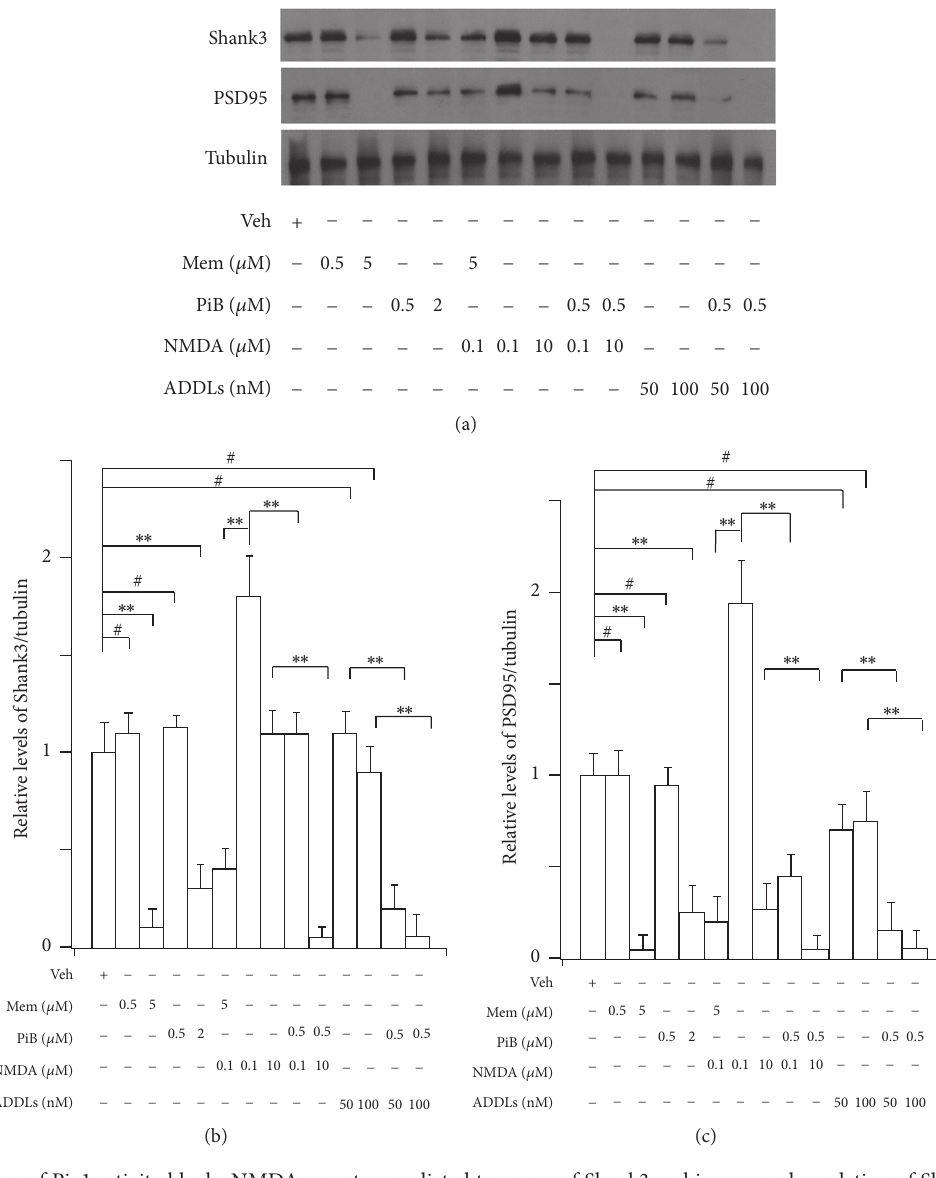
Figure 6: Blocking of Pin1 activity blocks NMDA receptor-mediated turnover of Skank3 and increases degradation of Shank3 and PSD95 induced by oligomers of A 𝛽 and NMDA in cultured neurons. Cortical neurons at 15 DIV were incubated with memantine, NMDA, PiB, and oligomers of A 𝛽 for 24 h. (a) Representative Western blot. (b and c) Results from densitometric imaging of these tests. Memantine 10 𝜇 M significantly decreased levels of Shank3 and PSD95 proteins. NMDA 100nM significantly increased levels of these proteins, and 10 𝜇 M memantine significantly inhibited the increase of Shank3 induced by 100 nM NMDA. When 10 𝜇 M NMDA and 0.5 𝜇 M PiB were incubated with neuron together, these proteins were significantly decreased. The same results were observed between PiB and oligomers of A 𝛽 from seven independent experiments ( 𝑛 = 7 dishes for each experimental condition, ∗∗ 𝑝 < 0.001 , # 𝑝 > 0.05 ).